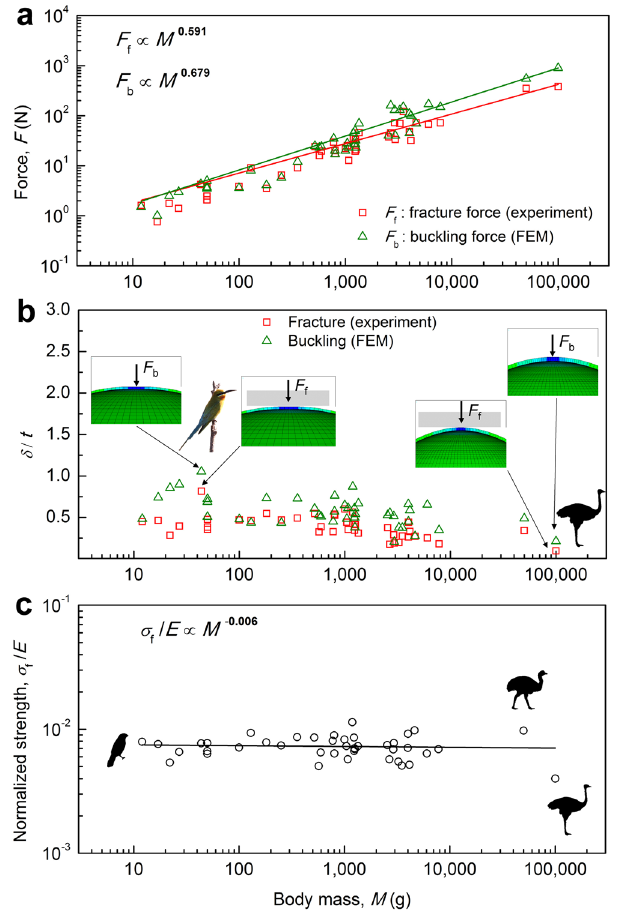
Figure 5. Failure characteristics of avian eggshells. ( a ) Experimental fracture force and simulated buckling force. ( b ) The displacement to shell thickness ratio δ / t at fracture (red squares) and buckling (green triangles). Much of the displacement comes from the bending deformation (flattening) near the contact zone. ( c ) Normalized fracture strength is approximately invariant: σ f / E = 0.73 ± 0.16%, or σ f = E /137, see Fig. S7. A theoretical upper limit of σ f is between E /2 π and E /30 (ref. 38 ). Fracture data are obtained from the compression test; buckling data are predicted by FEM simulations. See Supplementary Dataset 2 for details on the source of bird